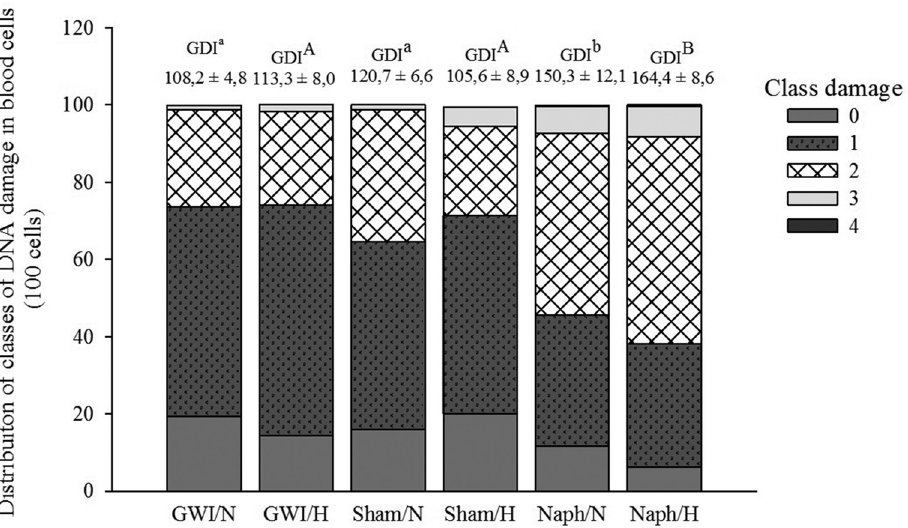
Figure 3 - Distribution of classes of DNA damage in C. macropomum blood cells in the three experimental groups: Group Without Injection (GWI); Group with corn oil injection (Sham); and Group naphthalene injection (Naph) after 96 h normoxia exposure (N) followed by 6 h of hypoxia (H). The Ge- netic Damage Index (GDI) is identified in each treatment (on the bars). Small cap letters (a and b) indicate statistical difference among treatments in normoxia. Capital letters (A and B) indicate statistical difference among hypoxia treatments. The statistical significance value was p